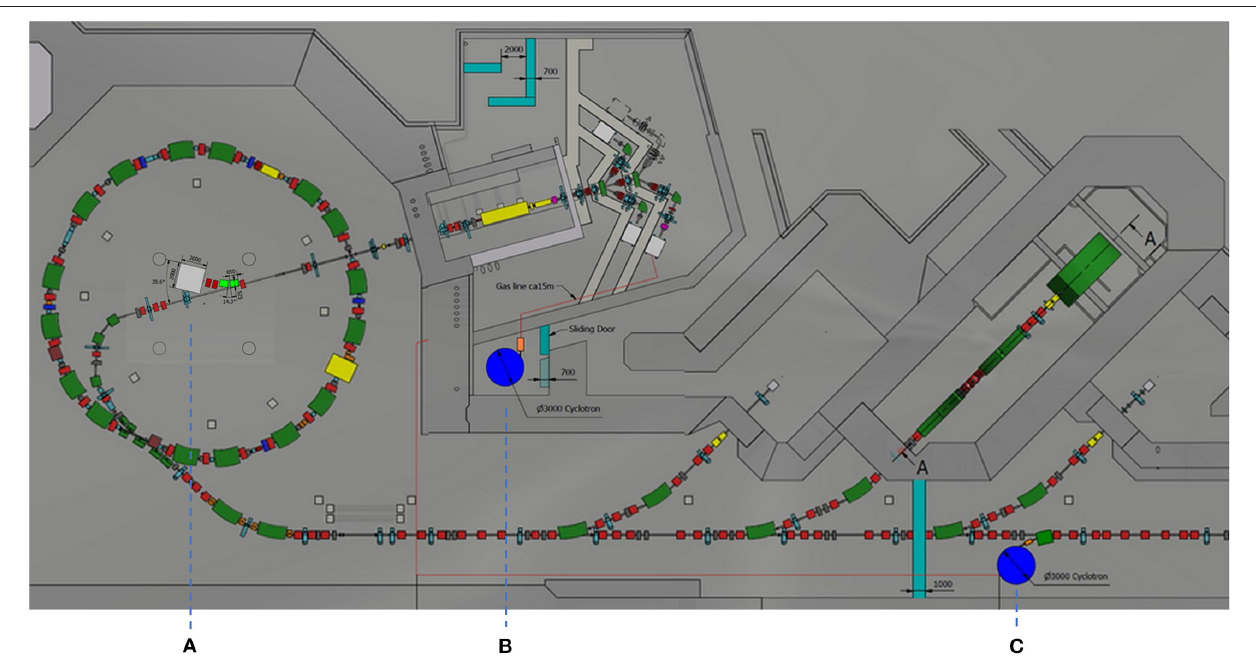
FIGURE 14 | (A) Potential production facility layout in the existing Linac: a new fast deflector deviates the beam sufficiently to hit two magnetic septa (green) which steer the beam toward an activation target housed in a concrete shielding. (B) Medical Cyclotron (blue) option to enable parallel beam operation with protons on the Gantry, additional concrete walls (turquois) in the extraction line and at entrance of the injector hall. The production target is connected to the Injector hall via a long gas feed line. (C) Radiopharma Cyclotron (blue) solution implemented in the existing cool down area of IR1 which should also house the production target (orange). Additional radiation protection doors and mace will have to be installed to avoid new access restrictions in near installations.